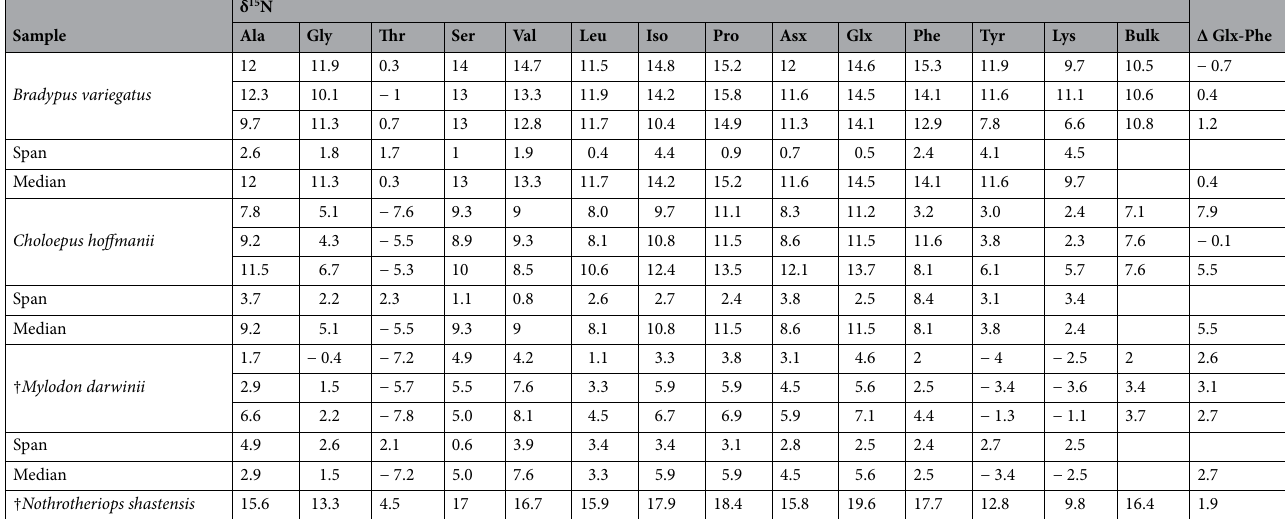
Table 1. AA and bulk tissue δ15N values (‰ vs. AIR) for modern (zoo) and fossil (†) sloth species (n = 3 for all species except Nothrotheriops ). ∆Glx-Phe is the offset between δ 15 N Glx and δ 15 N Phe values. Notice that the high ∆Glx-Phe in the two-toed sloth Choloepus is because it is fed a mixed animal-plant omnivorous diet at the